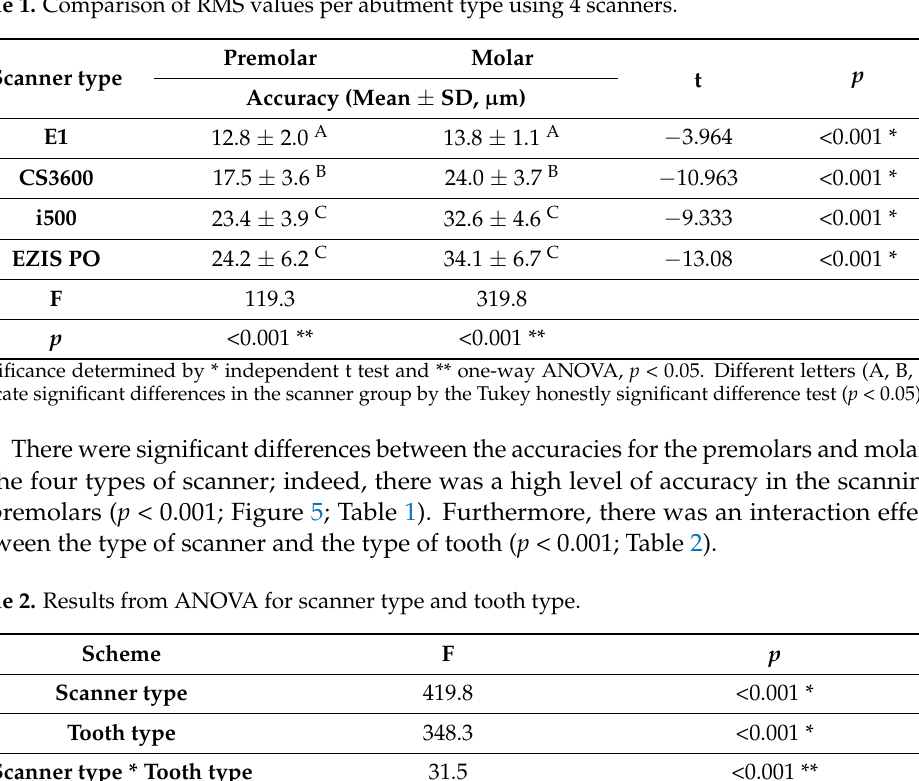
Figure 4. Comparison of RMS value according to scanner. Different letters (A, B, C) indicate significant differences in the scanner group in the Tukey honestly significant difference test ( p < 0.05). Table 1. Comparison of RMS values per abutment type using 4 scanners.